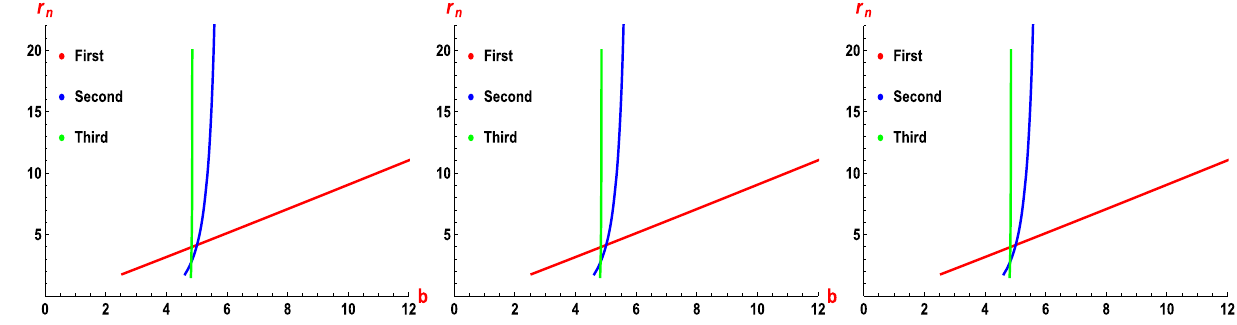
Fig. 5 The first three transfer functions of the BH under some specific values of the state parameters with M = 1. All the panels from left to right are plotted for numerical values of parameters as defined in top row of Table